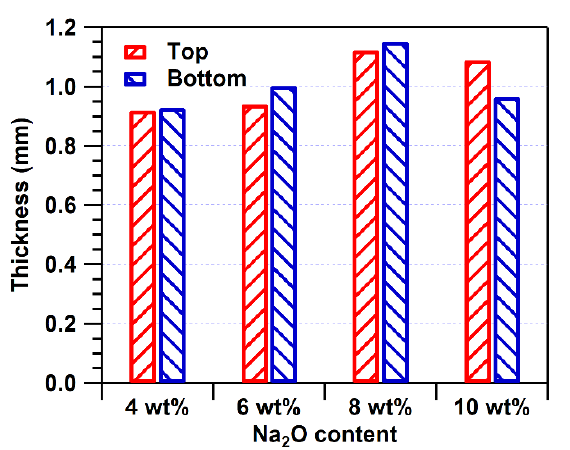
Figure 15. Thickness of paste on the surface of coarse aggregate in the pervious concrete prepared with various Na 2 O content.